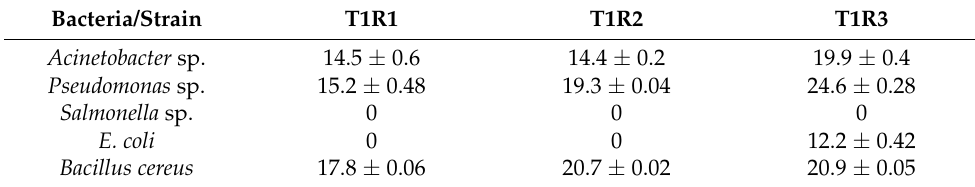
Table 2. Diameters (mm) of inhibition zones against different bacteria. Bacteria/Strain T1R1 T1R2 T1R3 Acinetobacter sp. Pseudomonas sp. Salmonella